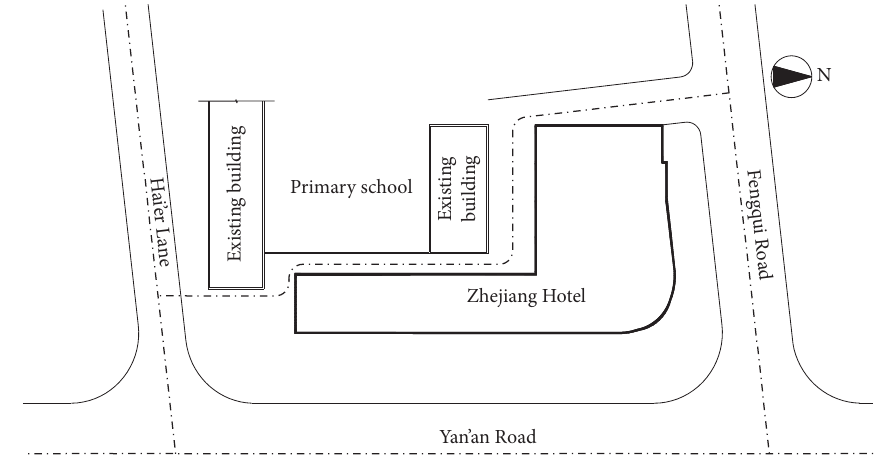
Figure 7: The layout of Zhejiang Hotel. Table 1: Physical and mechanical parameters of soil.